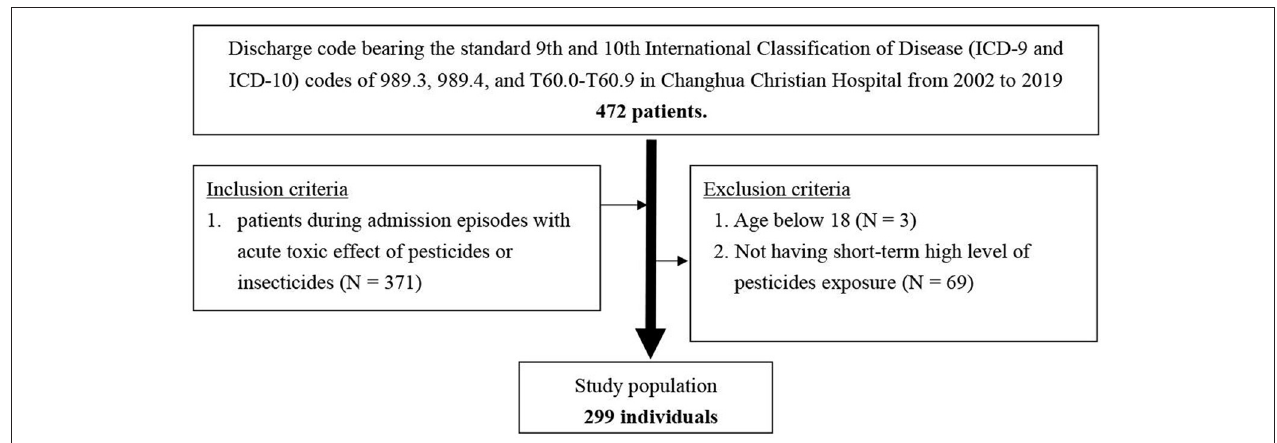
FIGURE 1 | Flowchart of study samples selection from Changhua Christian Hospital.